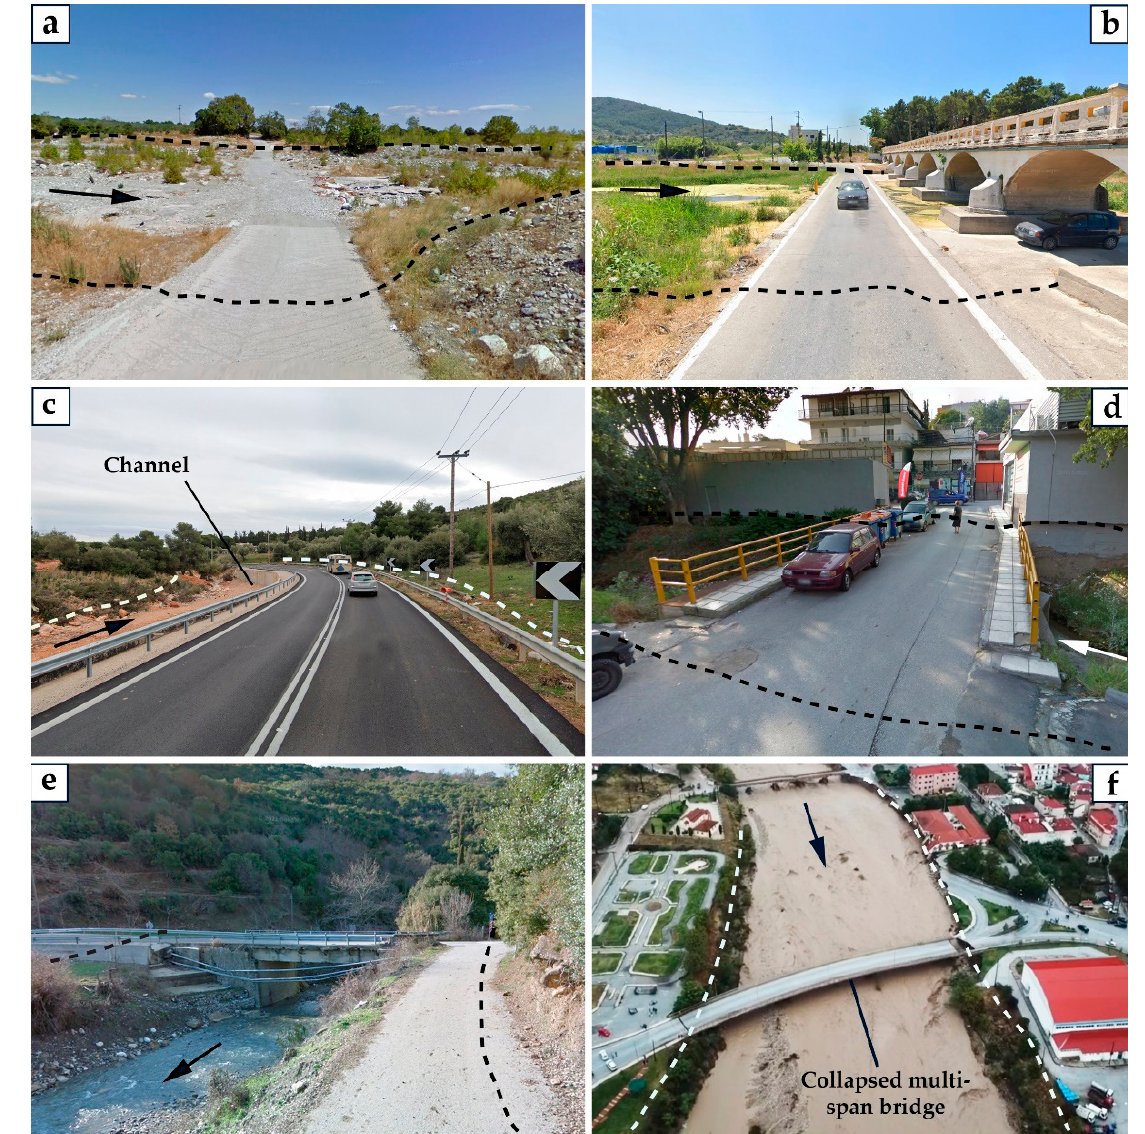
Figure 2. Typical examples of infrastructure in locations where people lost their lives, including ( a ) an unimproved ford crossing, ( b ) an improved but unvented ford crossing, ( c ) an asphalt road beside a river channel, ( d ) a low water bridge, ( e ) a single-span bride and ( f ) a collapsed multi-span bridge. The dashed lines and the arrows denote the approximate maximum extent of the inundated area during the event under study and the direction of flow, respectively. All the locations shown were included in the present study.